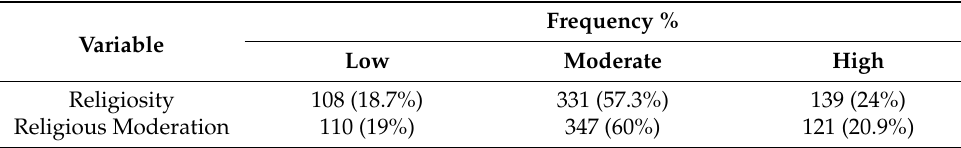
Table 3. Religiosity and religious moderation.